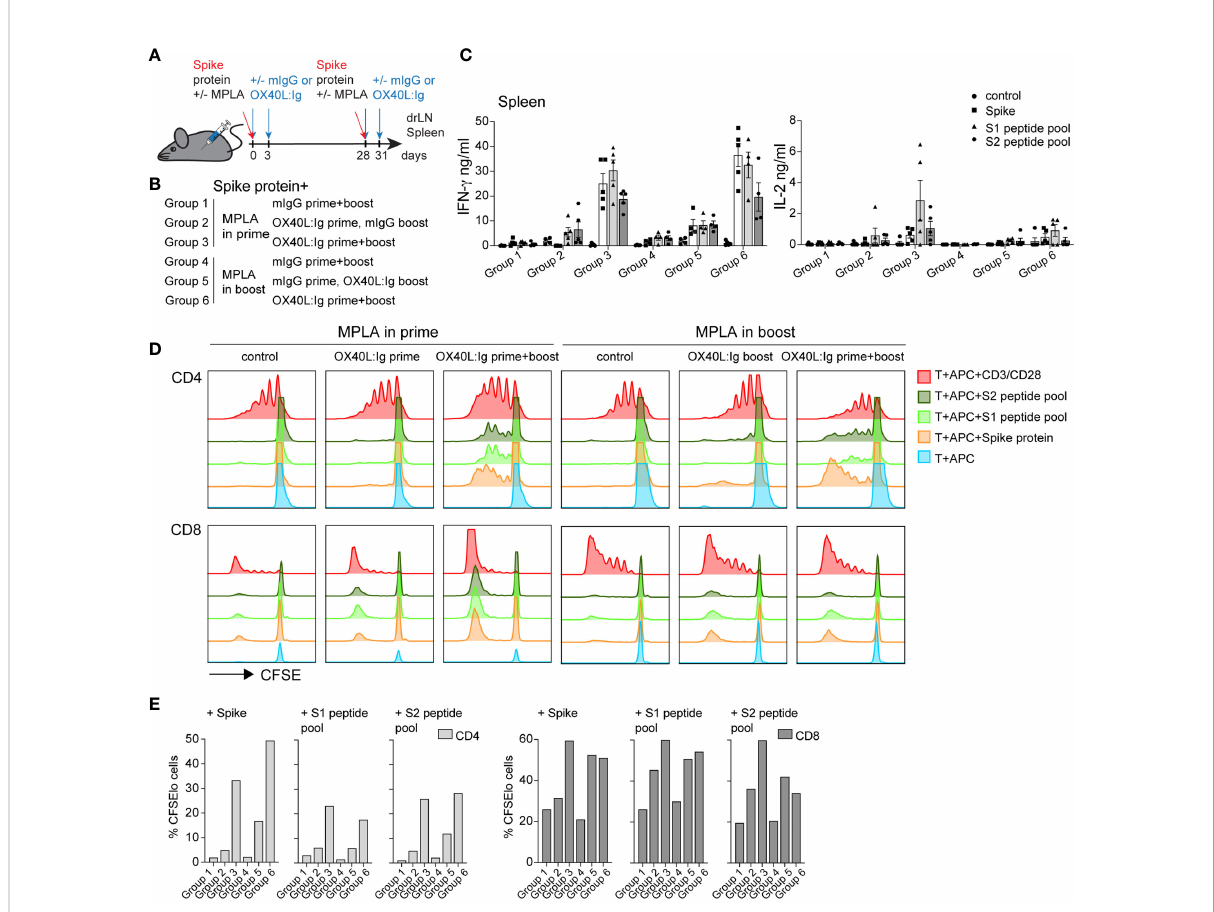
FIGURE 2 OX40 agonist enhances vaccine-speci fi c T cell responses independent of whether a TLR4 agonist was administered in the prime or the boost. Groups of mice were immunized with the SARS-CoV-2 spike protein emulsi fi ed in Montanide ISA 51 with MPLA injected in the prime or boost. In groups 1-3, mIgG or OX40L:Ig were administered in the prime with MPLA or OX40L:Ig was given in both prime and boost. Groups 4-6 received MPLA in the boost with mIgG or OX40L:Ig or OX40L:Ig was given in both prime and boost. (A) Schematic representation of immunization with the spike protein, MPLA and timing of the OX40L:Ig injections. (B) Description of the experimental group layout. (C) Secretion of IFN- g and IL-2 cytokines examined in the supernatant of splenocytes cultured for 3 days alone, in presence of spike protein, S1 or S2 spike peptide pools. Each data point represents an individual animal. Bars indicate mean ± SEM. (D) CFSE-labeled splenic T-cells, were cultured with irradiated APCs alone, pulsed with spike protein, or S1 and S2 spike peptide pools. CD3/CD28 stimulation was used as positive control for these experiments. Histograms show the cell division by dilution of CFSE as analyzed by fl ow cytometry after 4 days of culture, cells were gated on either CD4 or CD8 T cells. (E) Bar graphs showing the percentage of CFSE lo CD4 and CD8 T cells in 4-day cultures after spike antigen stimulation. 1 of 2 experiments is shown in (B – D)